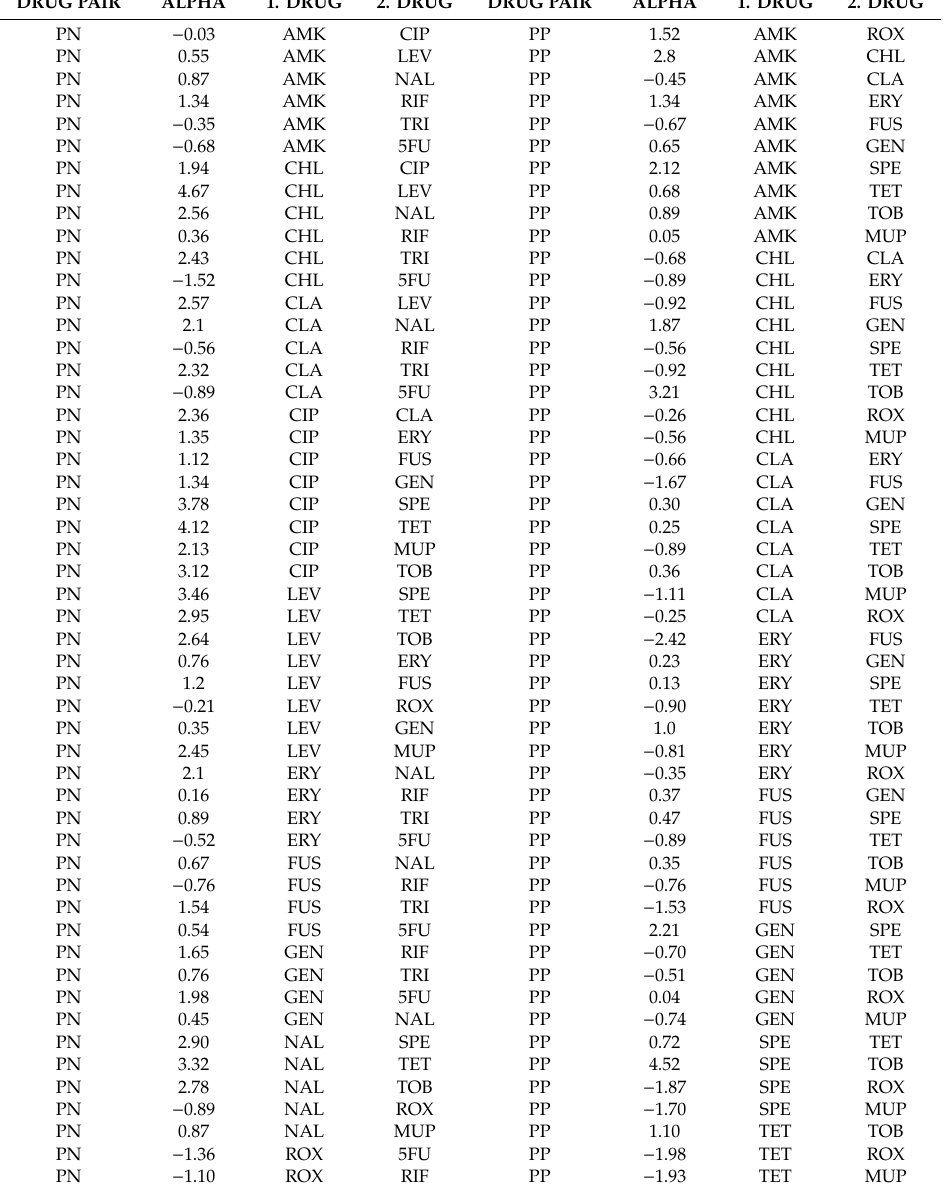
Table 3. Detailed pairwise drug interactions and alpha